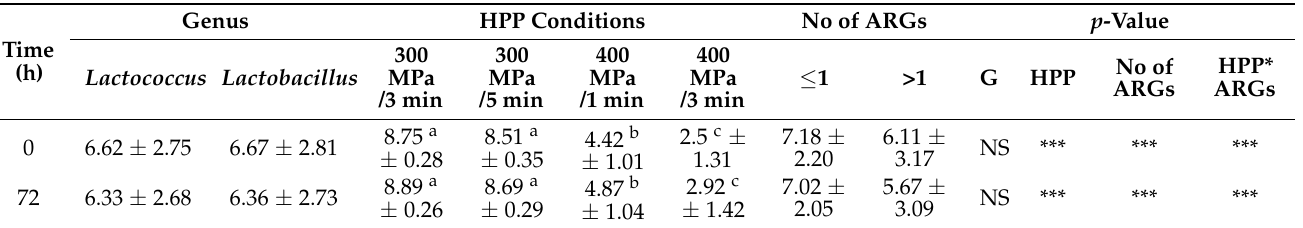
Table 3. Effect of the genus, pressure conditions, and number of antibiotic resistance genes on survival of the starter culture components (mean values of log CFU/mL ± SD).